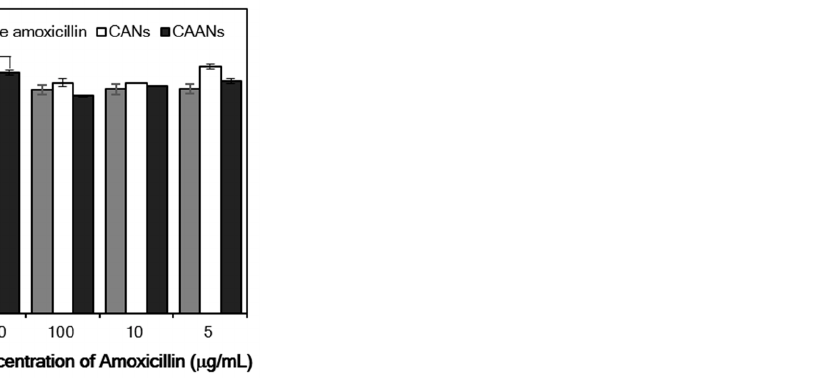
Figure 5. Relative cell viability of the NIH/3T3 fibroblasts treated with free amoxicillin, CANs, and CAANs at amoxicillin concentrations of 5, 10, 100, and 1000 μ g/mL. *: p < 0.05.